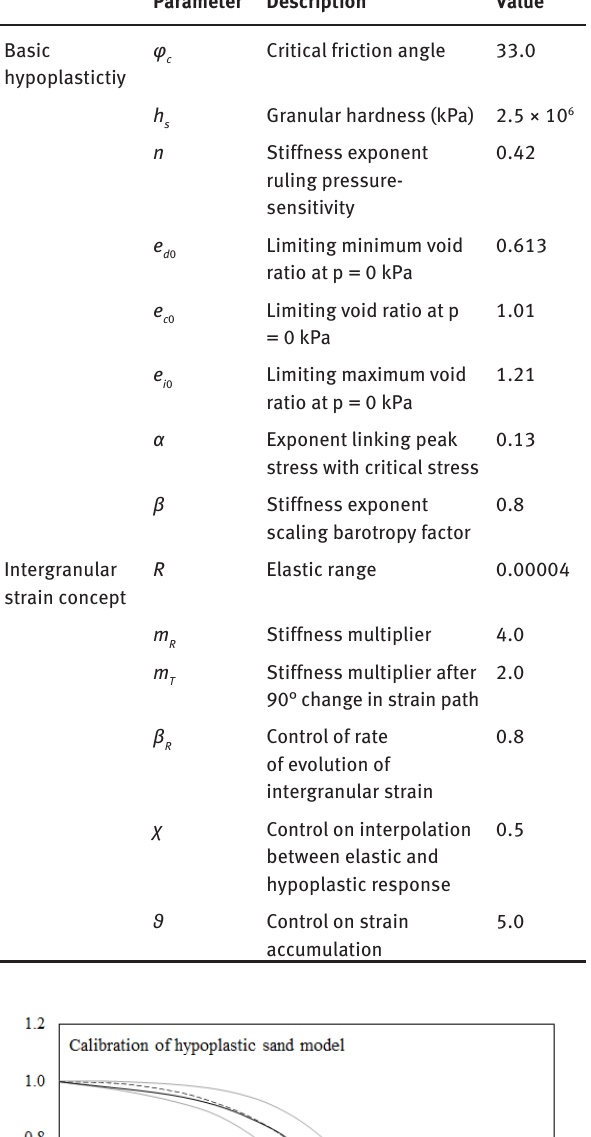
Table 1: Calibration of the model parameters for the hypoplastic sand